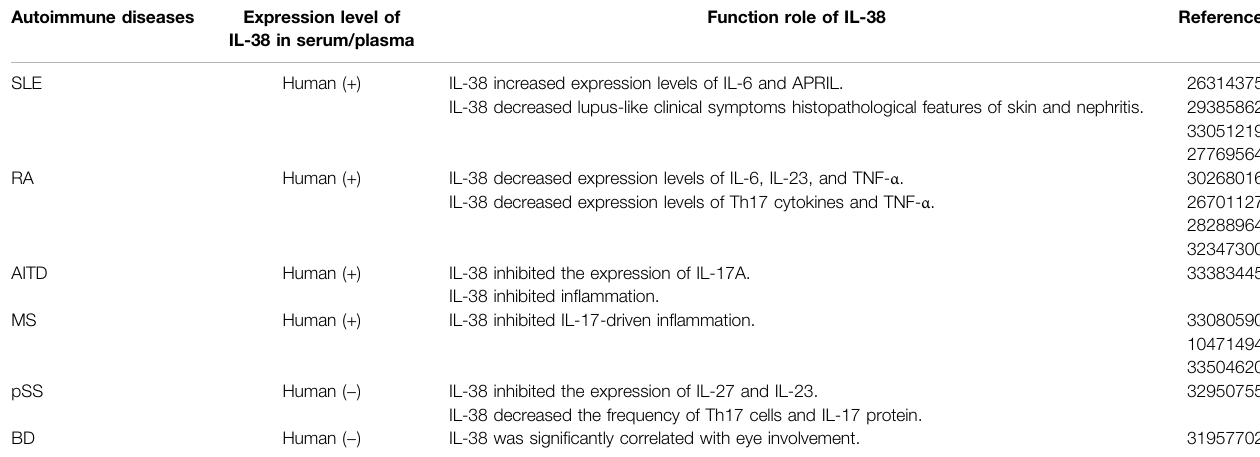
Function role of IL-38